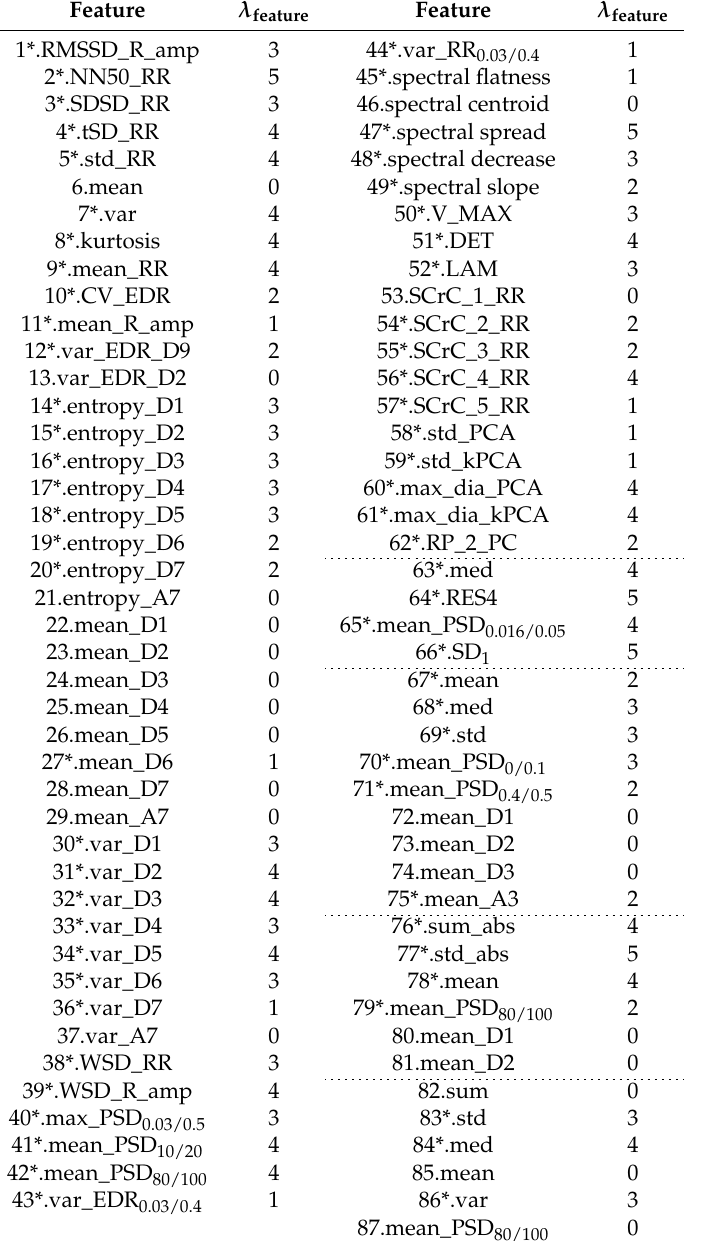
Table 1. Feature selection from PSG signals and their results (feature Nos. 1–62 from Electrocardiography (ECG) signals, Nos. 63–66 from SaO 2 signals, Nos. 67–75 from airflow signals, Nos. 76–81 from abdominal signals and Nos. 82–87 from thoracic signals. Dashed lines divide the table according to the features of different